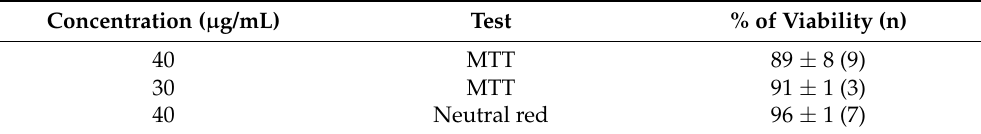
Figure 3. Effect of CdSe-QDs on the cell viability of the T98G human glioblastoma cells. T98G cells were exposed to different CdSe-QDs under the conditions described in Section 4.4. Cell culture viability was determined by the MTT test as described in Section 4.5. Each experimental condition was tested with six different wells of the same cell culture. Another independent experiment with an independent cell culture and six biological replicates per experimental condition yielded similar results. One hundred percent of viability was considered the viability of control (non-exposed) culture. Table 1. Effect of CdSe-QDs on the cell viability of the T98G human glioblastoma cells. The T98G human glioblastoma cells were exposed to NPs, as defined in Section 4.4 (Materials and Methods). Next, NPs were removed, and culture viability was determined by either the MTT or neutral red tests. The mean ± standard deviation of the percentage of viability for (n) independent experiments (run with independent cell cultures) is displayed. Each independent experiment was performed with six wells of the same cell culture. Each experiment was run simultaneously with a positive control of CuSO 4 that reduced cell viability by around